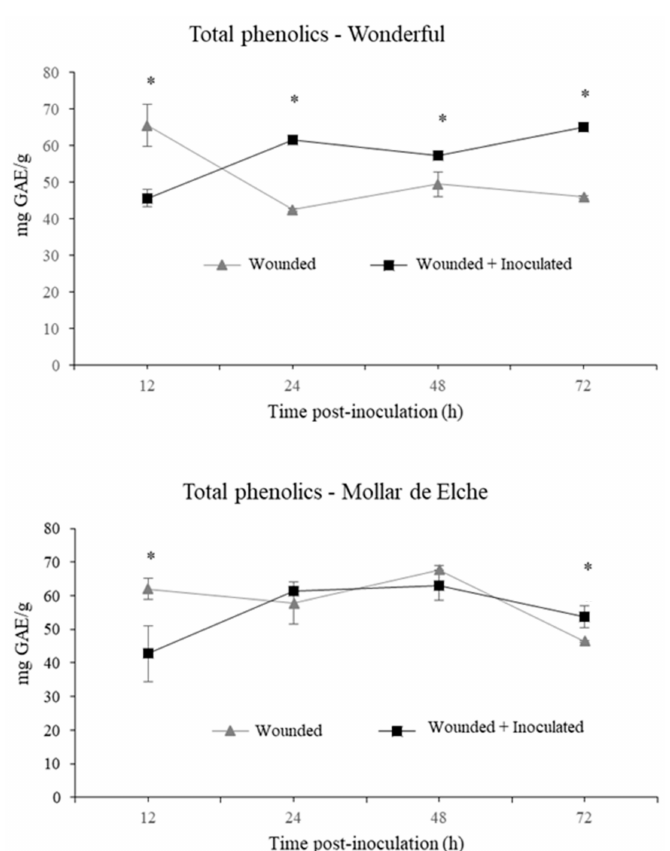
Figure 4. Total phenolics (mg / g GAE) in rinds of ‘Wonderful’ and ‘Mollar de Elche’ fruit inoculated by P. granati , as compared to the wounded ones at 12–72 h post-inoculation. Data are the mean of three experiments ± SEM. Time points with an asterisk are statistically di ff erent according to DMRT (* p <